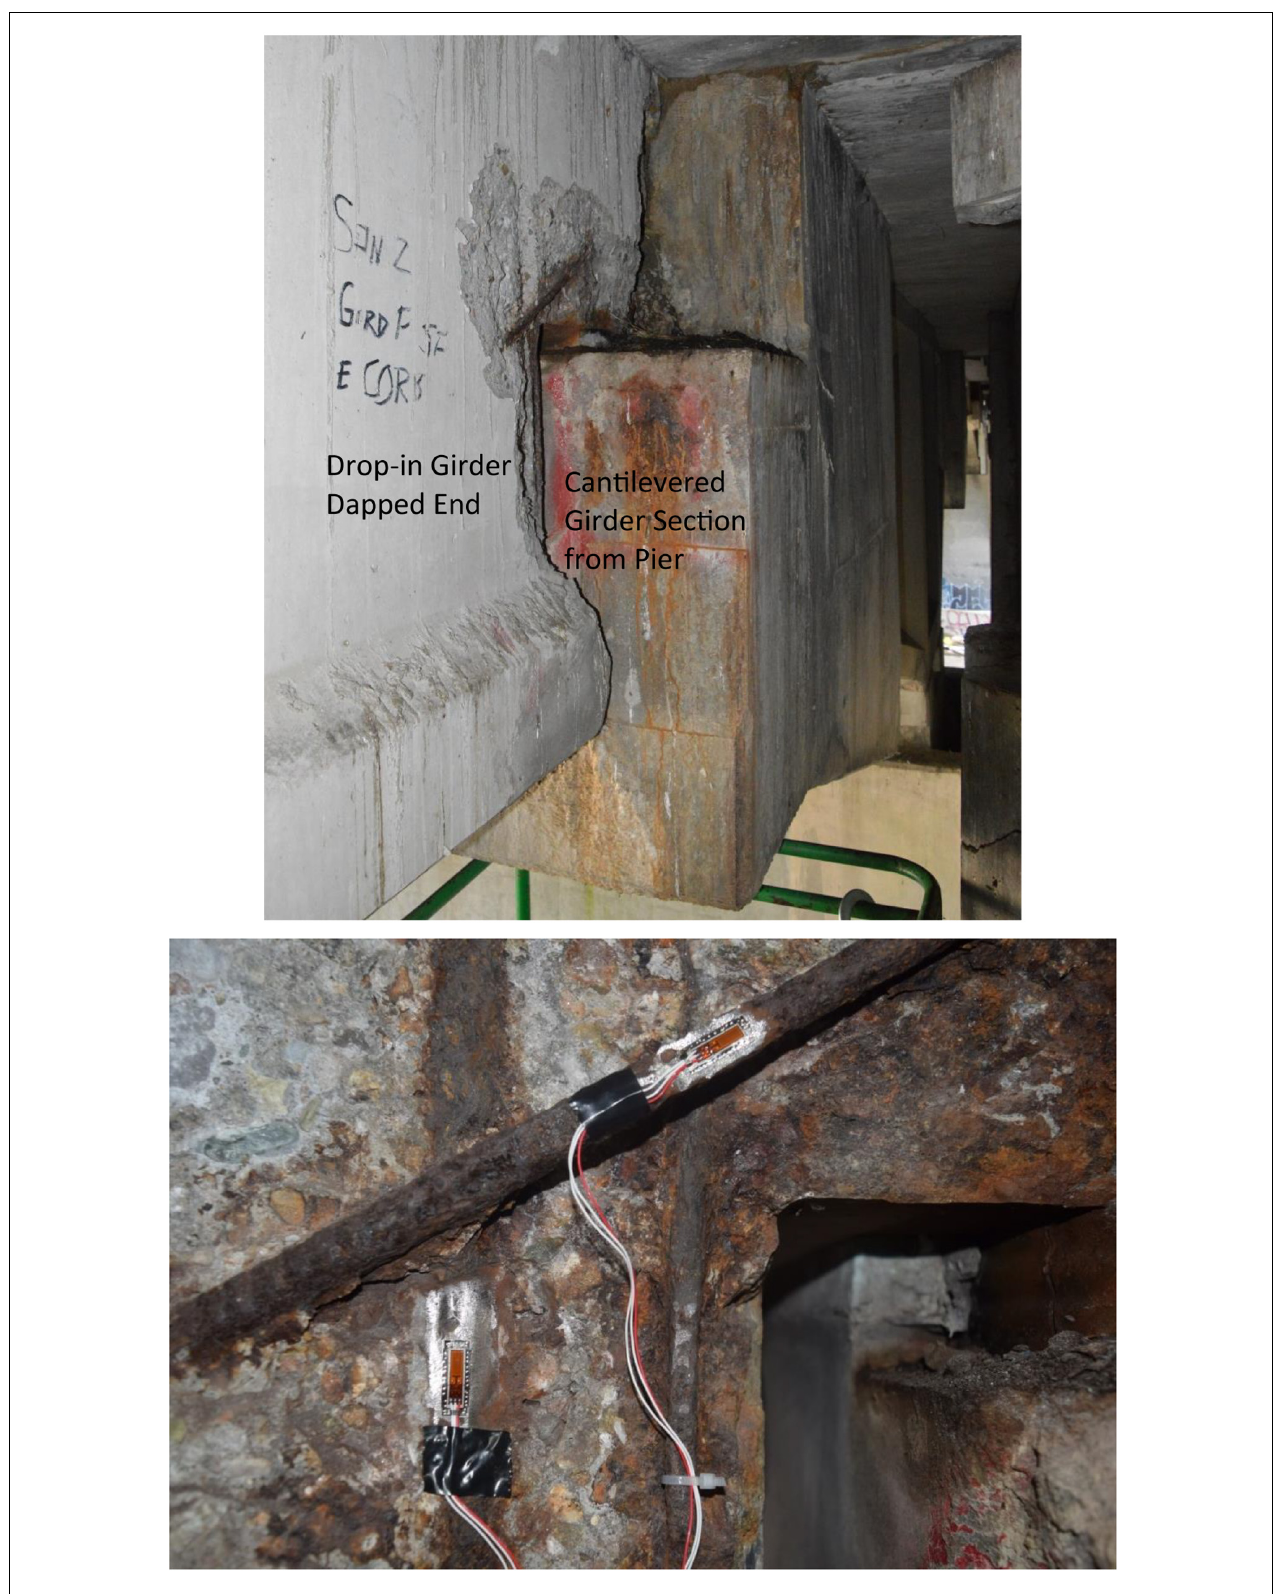
FIGURE 6 | Weldable strain gauges on exposed rebars at dapped end.